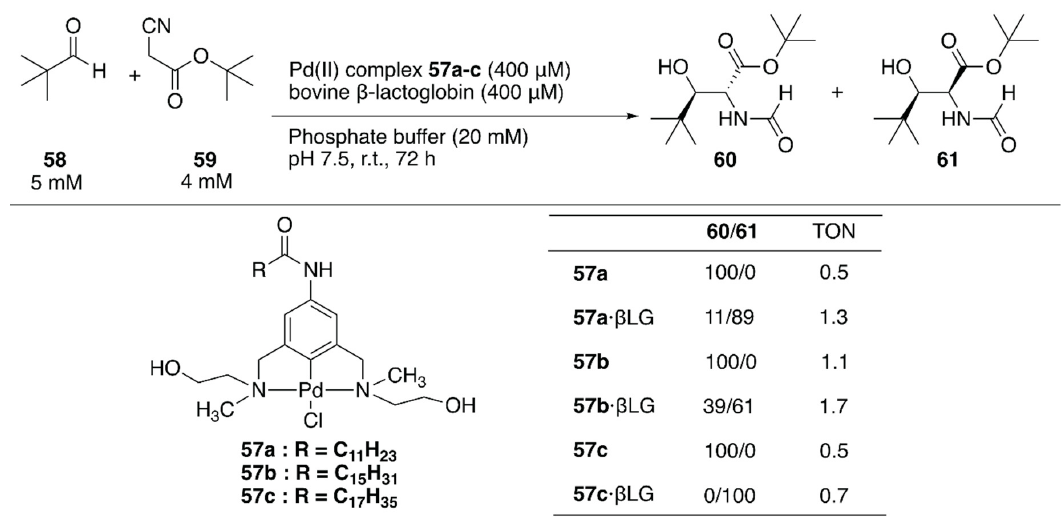
Figure 11. Aldol condensation of tert -butyl isocyanoacetate and pivalaldehyde catalyzed by ArMs containing a palladium center. Adapted from [86]. Molecules 2020 , 25 , x